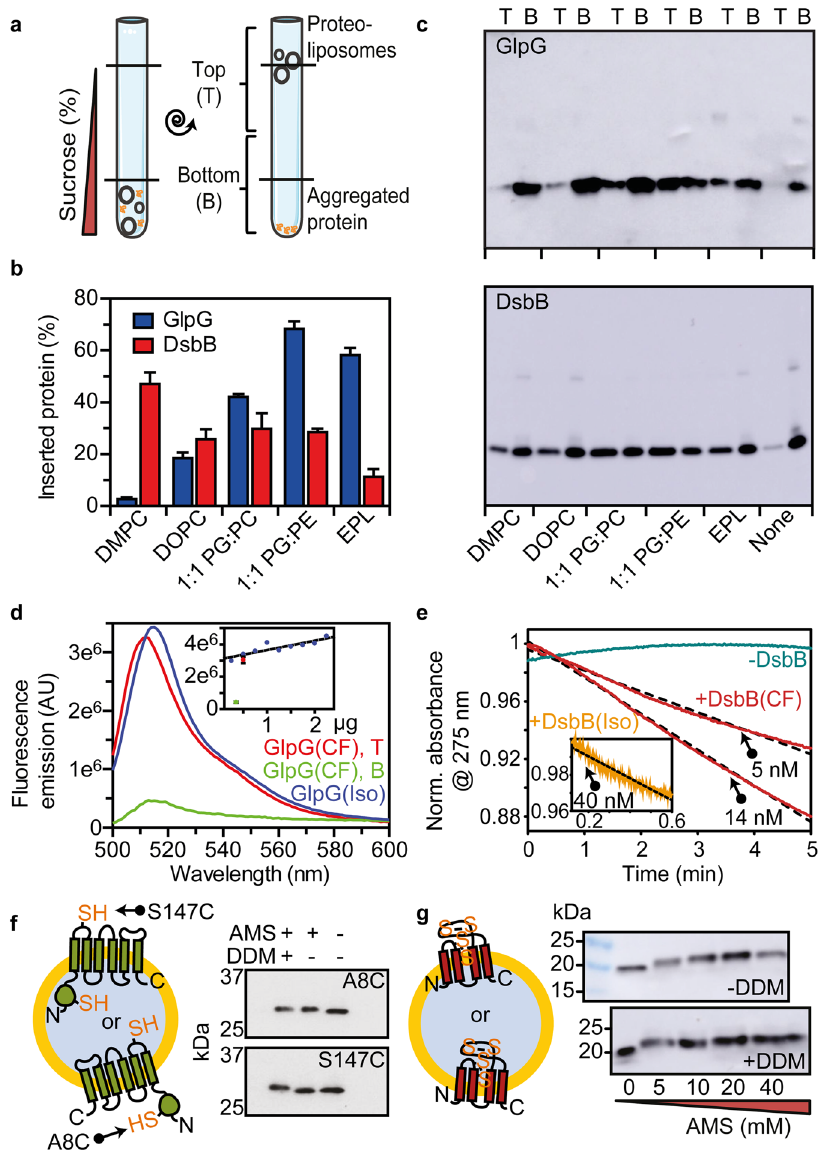
Figure 2. GlpG and DsbB cell-free synthesis. ( a ) Sucrose flotation assay to separate proteoliposomes (top, T) from non-inserted and aggregated protein (bottom, B). ( b ) The amount of inserted protein in the floated proteoliposomes was quantified via the [ 14 C]-Leucine or [ 35 S]-Methionine incorporated during protein synthesis, and expressed as a percentage of the total protein synthesised. Error bars are the SEM from at least three repeats. ( c ) Western blot analysis of the top and bottom sucrose gradient fractions of cell-free produced GlpG and DsbB. ( d ) Fluorescence spectra of GlpG protease activity of a soluble BODIPY-tagged casein. Cell- free (CF, top (red) and bottom (green)) or in vivo expressed and isolated (Iso, blue) GlpG were in DOPE:DOPG (1:1 mol ratio) liposomes. Inset: the fluorescence band maxima of GlpG protease activity versus GlpG concentration. ( e ) DsbB redox functional assay with DsbA and ubiquinone; reduction of ubiquinone results in a strong decrease in absorbance at 275 nm. Cell-free (CF, red) or in vivo expressed and isolated (Iso, orange) DsbB were in DMPC liposomes; a control sample without DsbB (green) is shown. Least-squared fitted linear fits (dashed black lines) calculating the initial rate of quinone reduction are shown. Possible topology of GlpG ( f ) and DsbB ( g ) after cell-free synthesis and insertion into liposomes (gold membrane with blue liposome interior). GlpG mutants (A8C and S147C) were used as AMS labelling sites to interrogate topology. DsbB contains two disulphide bonds within its periplasmic loops which, if exposed on the outside of the liposome, become available for AMS labelling upon TCEP